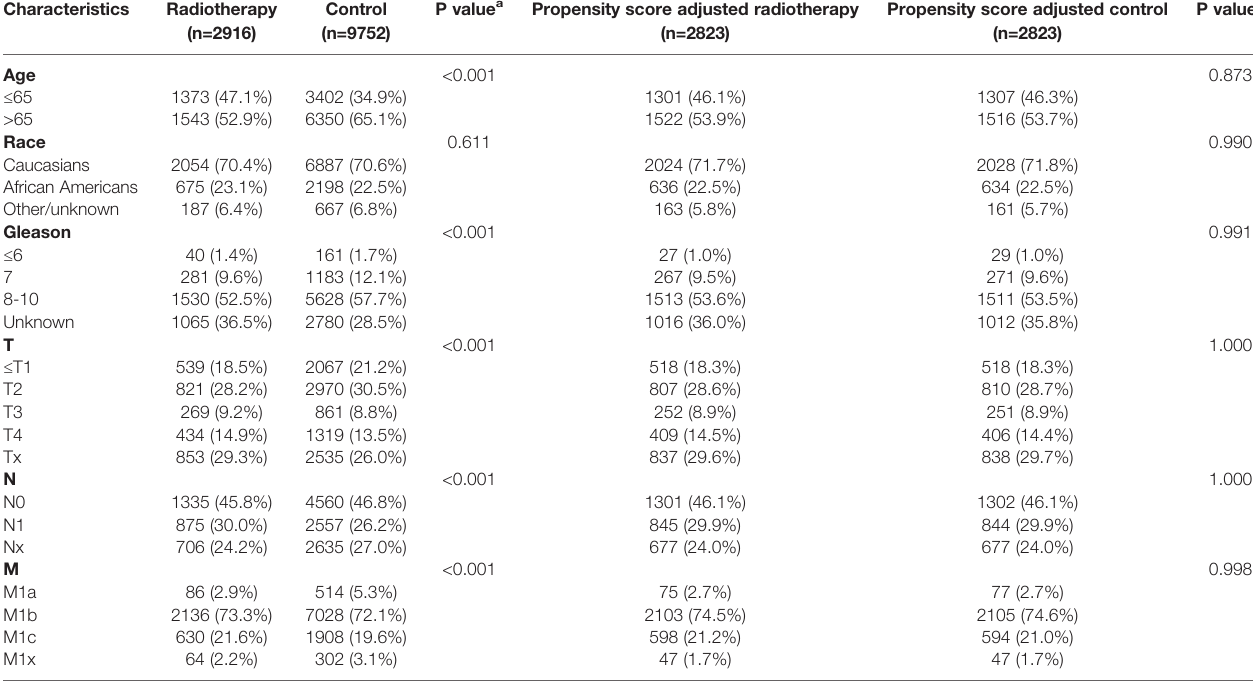
TABLE 8 | Clinicopathological characteristics of the PSA >80.1 ng/ml subgroup strati fi ed according to treatment modality with and without propensity score matching.